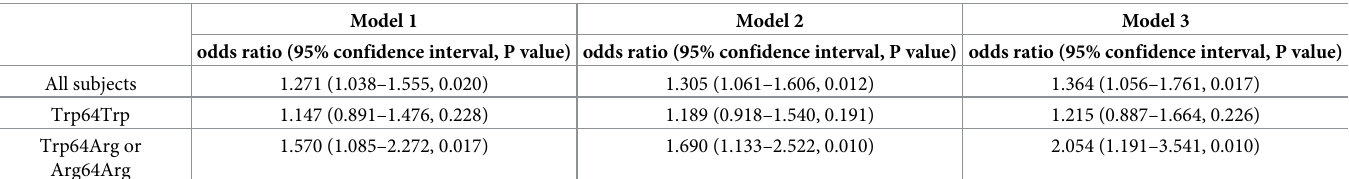
Table 5. Relationship between HOMA-IR and blood pressure according to the ADRB3 polymorphism at rs4994. Model